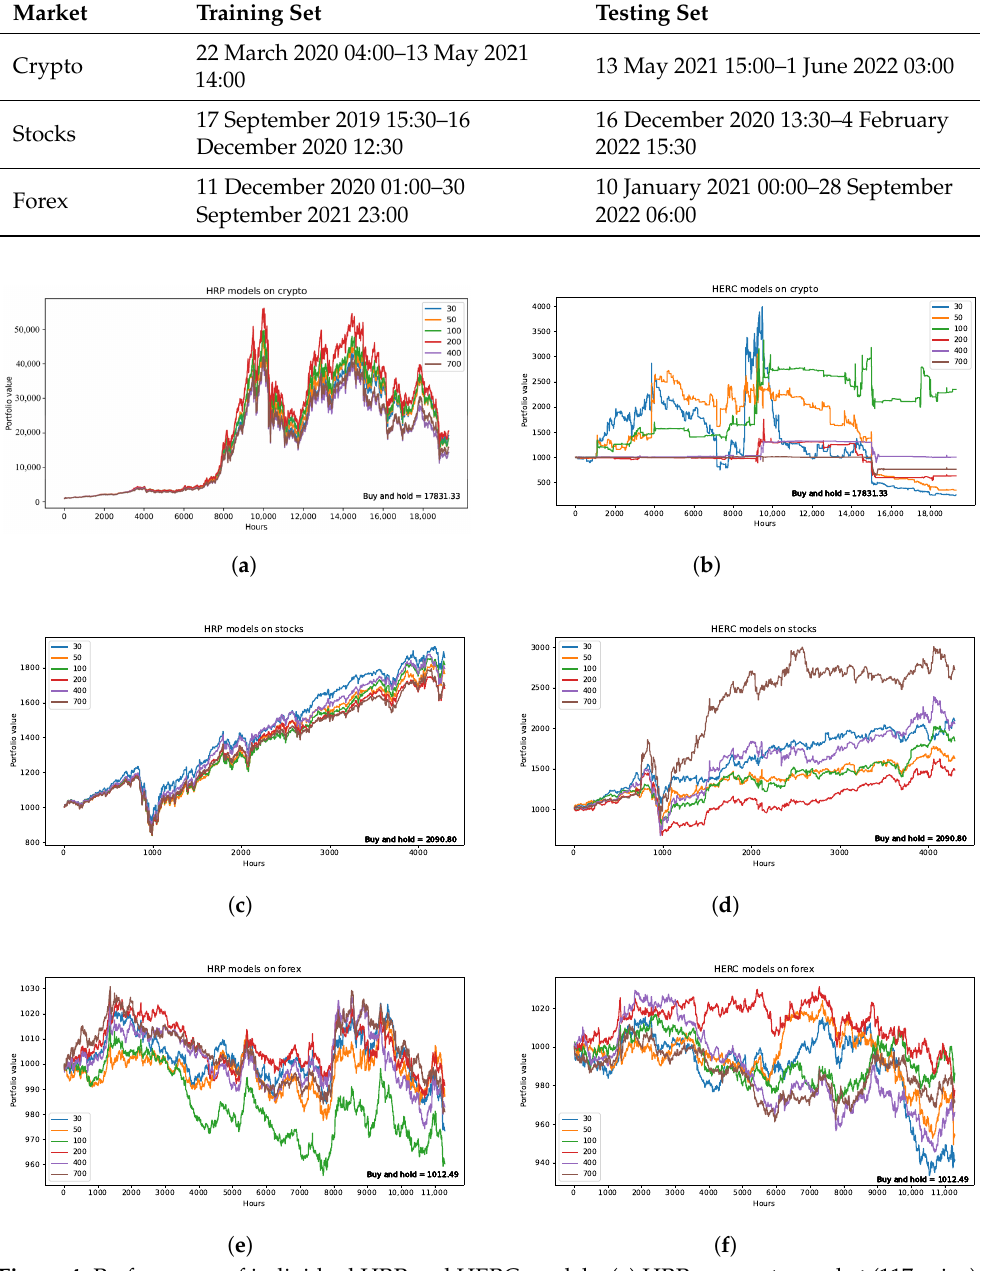
Figure 4. Performance of individual HRP and HERC models. ( a ) HRP on crypto market (117 coins); ( b ) HERC on crypto market (117 coins); ( c ) HRP on stock market (46 stocks); ( d ) HERC on stock market (46 stocks); ( e ) HRP on forex (28 pairs); ( f ) HERC on forex (28